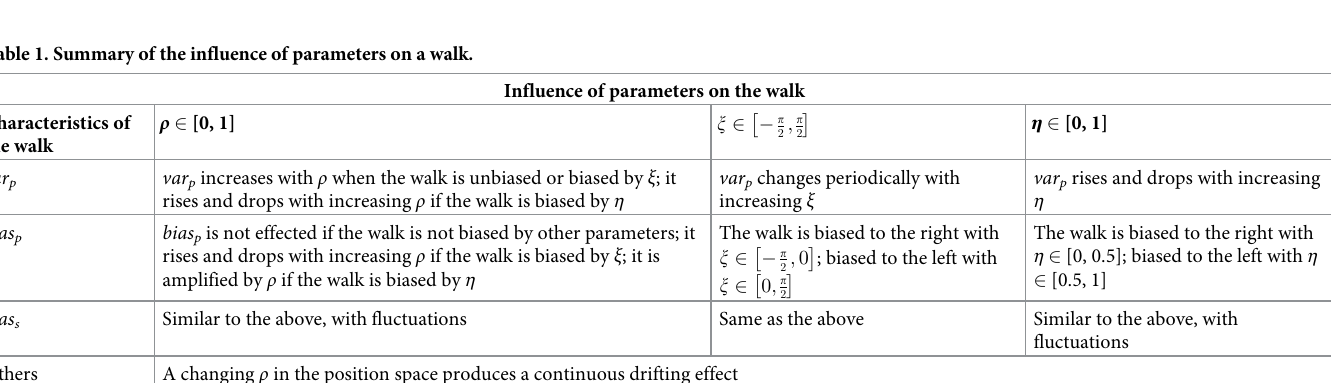
Table 1. Summary of the influence of parameters on a